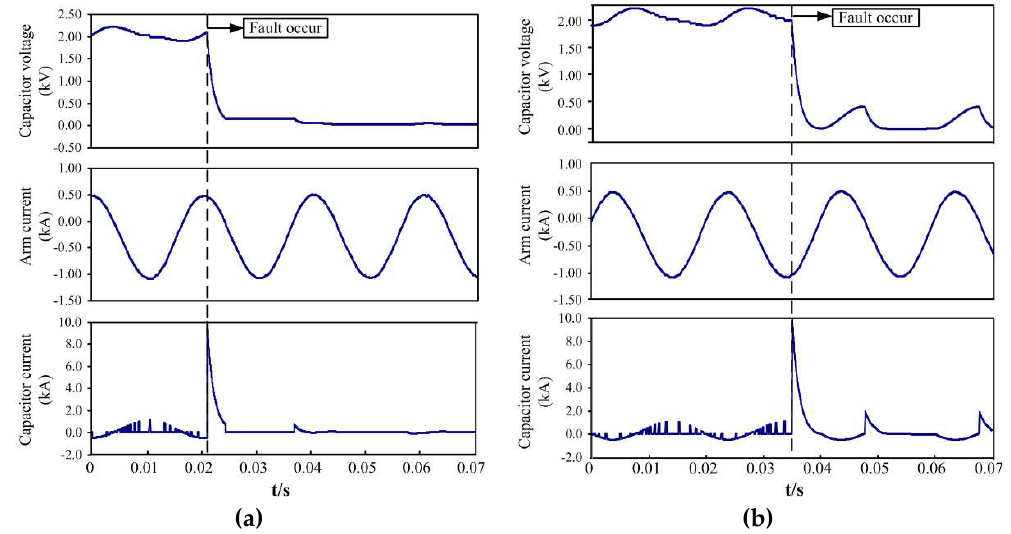
Figure 8. Performance of MMC under faulty operation: ( a ) Case 1; ( b ) Case 2.